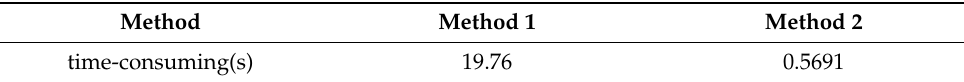
Table 5. Time-consuming comparison under 0.01 parameter